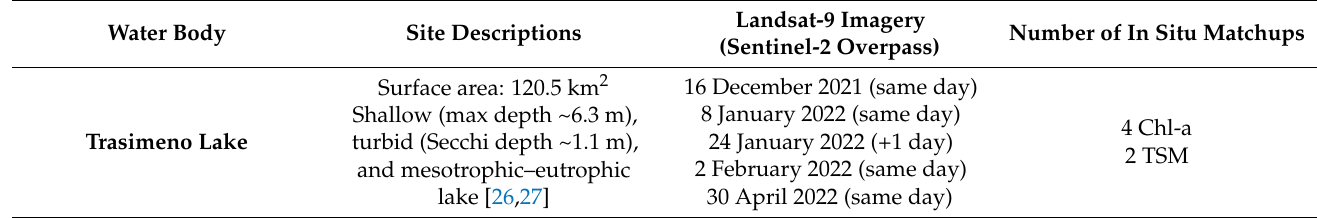
Figure 1. The location of studied ( a ) lakes in Italy and ( b ) San Francisco Bay in the United States. Table 1. Site descriptions, image acquisition dates, and the number of in situ samples for each case